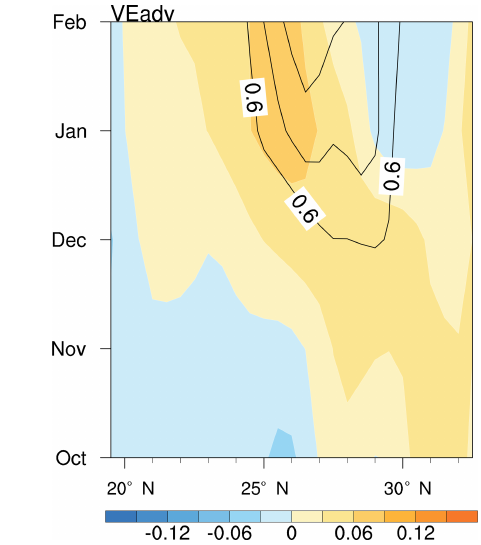
Figure 8. Same as Fig. 5c, except for the meridional temperature advection term calculated by the Ekman velocity.